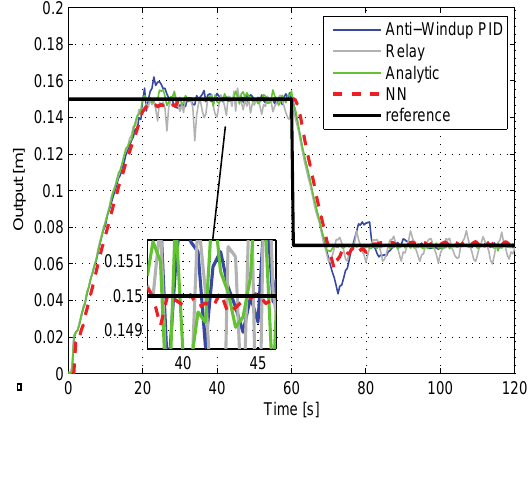
Fig. 6. Comparison results: outputs.